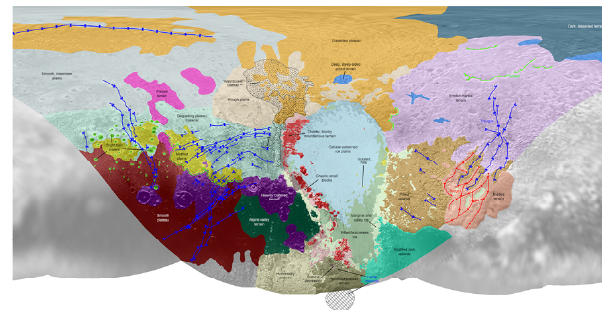
Figure 1. Simple cylindrical global projection of a physiographic province map for Pluto. 180° longitude is located at the center of the figure. This figure should NOT be interpreted as a geological map, rather it provides a general indication of where terrains have been recognized on Pluto. Terrains within low-resolution zones are not mapped.